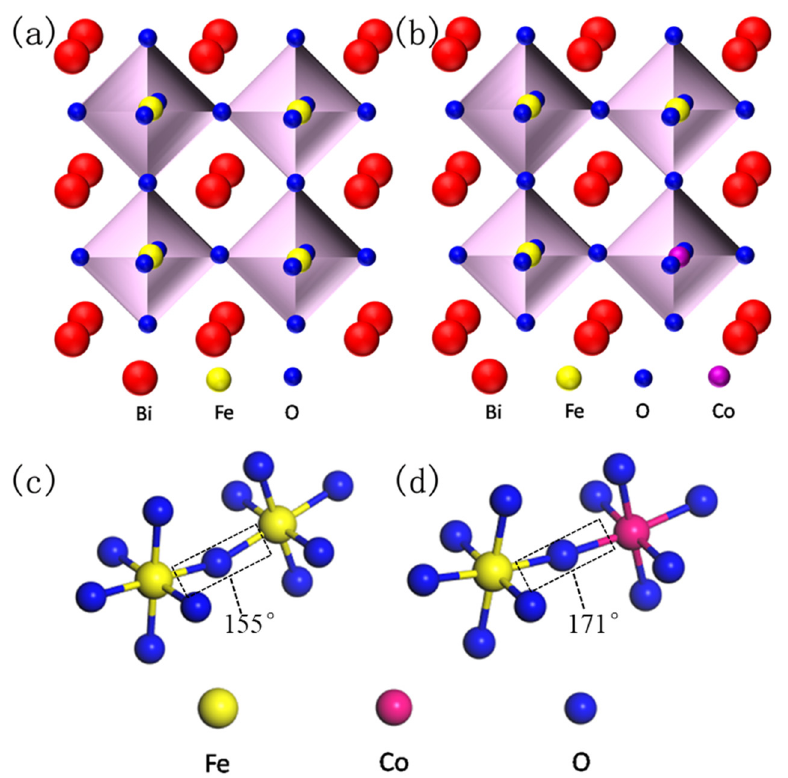
Figure 1. Simulated crystal structure of perovskite BiFeO 3 (BFO) ( a ) and Co substitution BFO ( b ), and the corresponding super-exchange interaction of Fe–O–Fe ( c ) and Fe–O–Co ( d